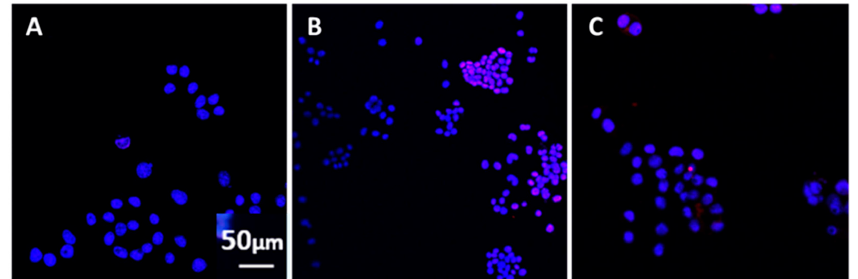
Figure 6. N2A cell apoptosis of cells in medium ( A ), exposed to the influenza vaccine ( B ) and ( C ) in the simultaneous presence of influenza vaccine and antibodies against H1N1. Similar e ff ects were observed when antibodies to H3N2, and S. Typhi were used. The antibodies were added to the culture medium simultaneously with the corresponding vaccine for two days. In the presence of the influenza vaccine, most nuclei were stained red with TUNEL indicating apoptosis (B), whereas, in the combined presence of the influenza vaccine and anti-H1N1 antibodies (C), most nuclei appeared healthy and stained with DAPI, similar to control cells cultured in medium